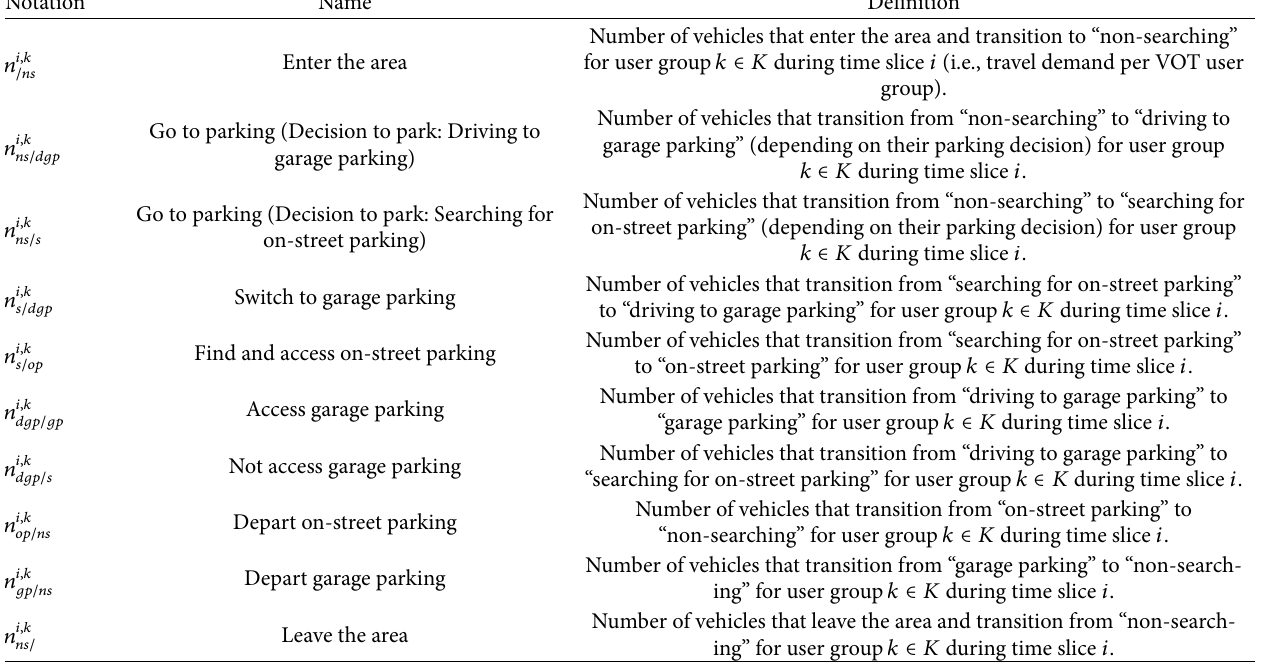
Table 4: All transition event variables for the on-street and garage parking-state-based matrix per time slice.